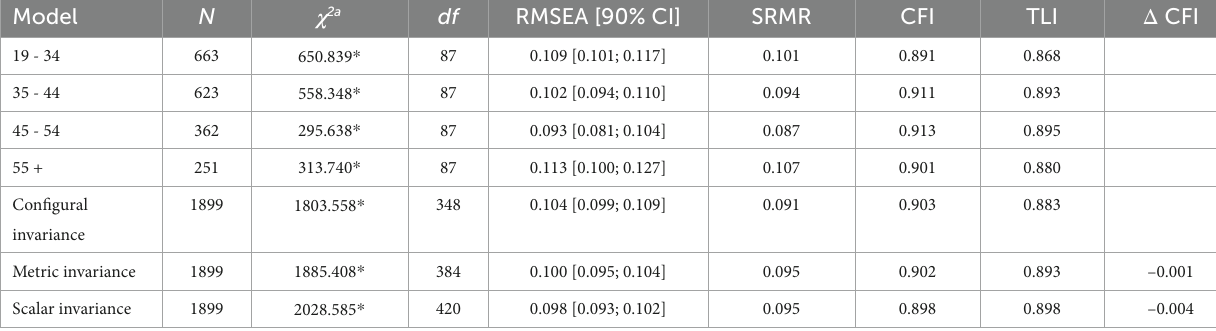
TABLE 4 Fit indices for single CFAs and measurement invariance models across age groups.